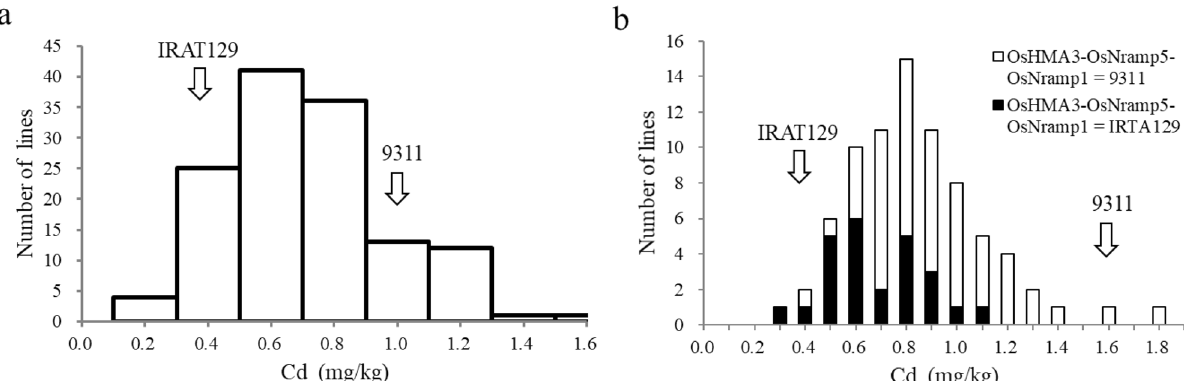
Figure 1. Phenotypic distributions of brown rice Cd concentration in RILs. ( a ) Distributions of brown rice Cd concentration of RILs in the 2016 middle-season rice growing season. ( b ) Distribution of brown rice Cd concentration and its association with the two genotypic groups of 78 lines from RILs across 2016 and 2017 middle-season rice growing season. OsHMA3 - OsNramp5 - OsNramp = 9311, carrying OsHMA3 - OsNramp5 -